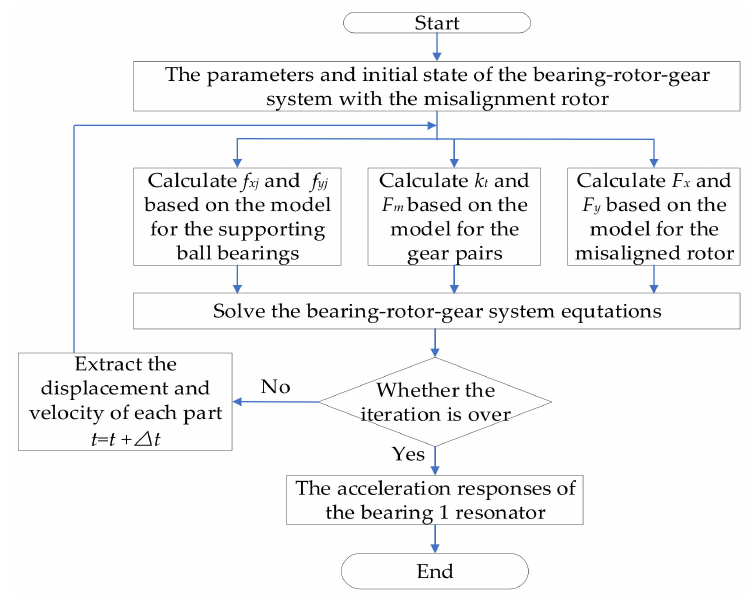
Figure 5. The flow chart of the calculation process.